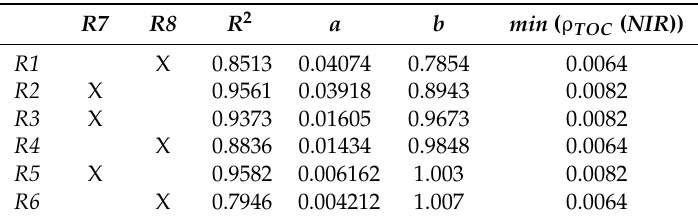
Figure 3. Linear fitting of the green (R3) and NIR1 (R7) WV-2 bands. Table 1. Linear NIR and visible band fitting